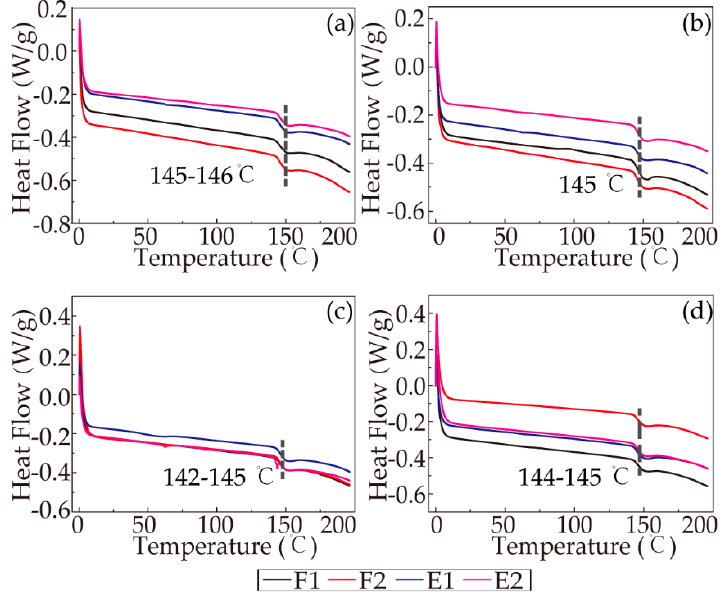
Figure 8. DSC curves of the cool-reheat scans: (a) 19%; (b) 22%; (c) 25%; (d) 28%.